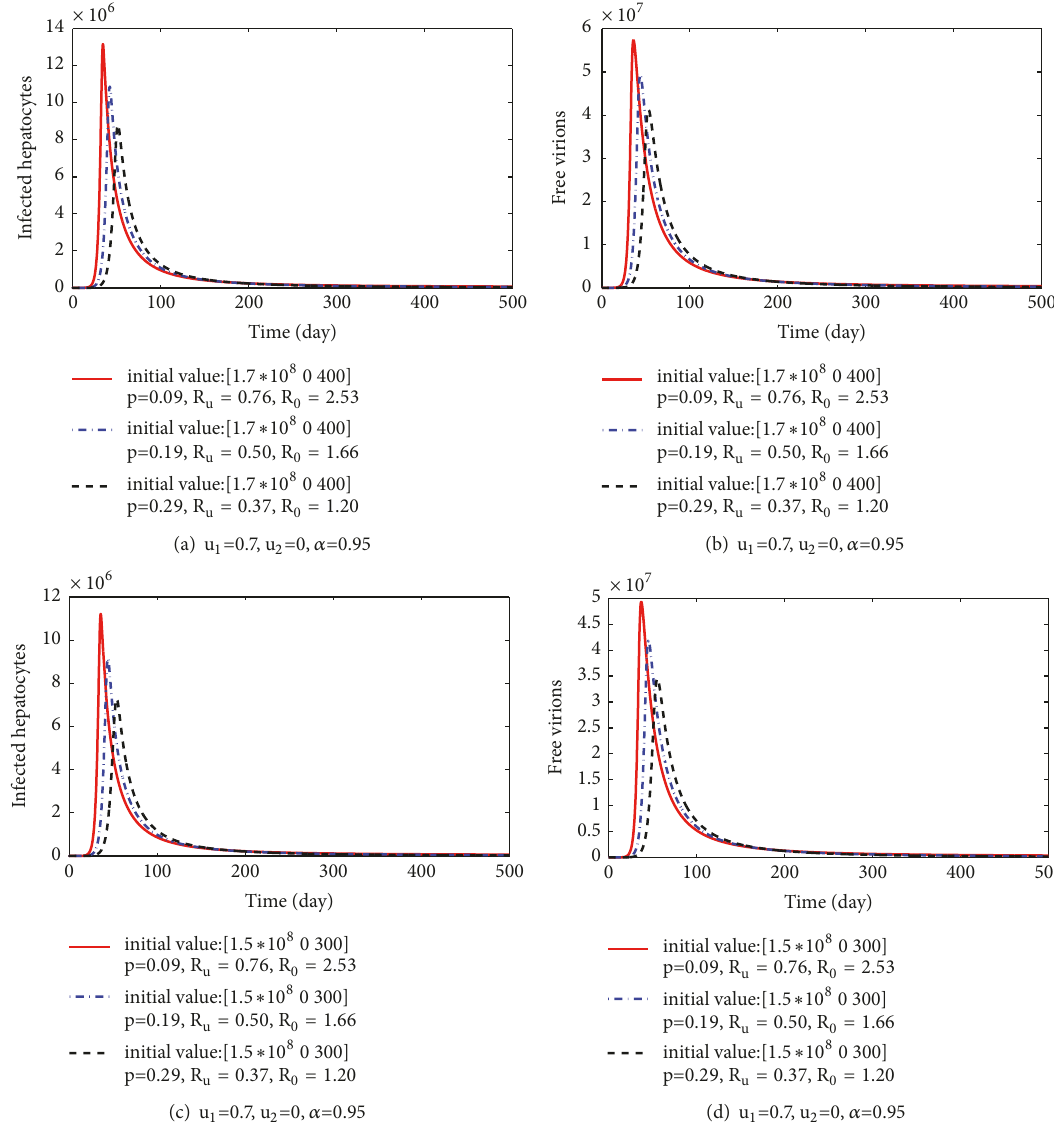
Figure 4: In this case, only IFN(without LAM) is used to treat HBV. For different values of 𝑝 , when 𝑅 𝑢 < 1 < 𝑅 0 , the disease-free equilibrium 𝐸 0 = (Π/𝛿, 0, 0) = (1.667 × 10 8 ,0,0) is asymptotically stable. The initial conditions of (a) and (b) are as follows: [ 1.7 × 10 8 0 400]; the initial 𝑢 conditions of (c) and (d) are as follows: [ 1.5 × 10 8 0 300].